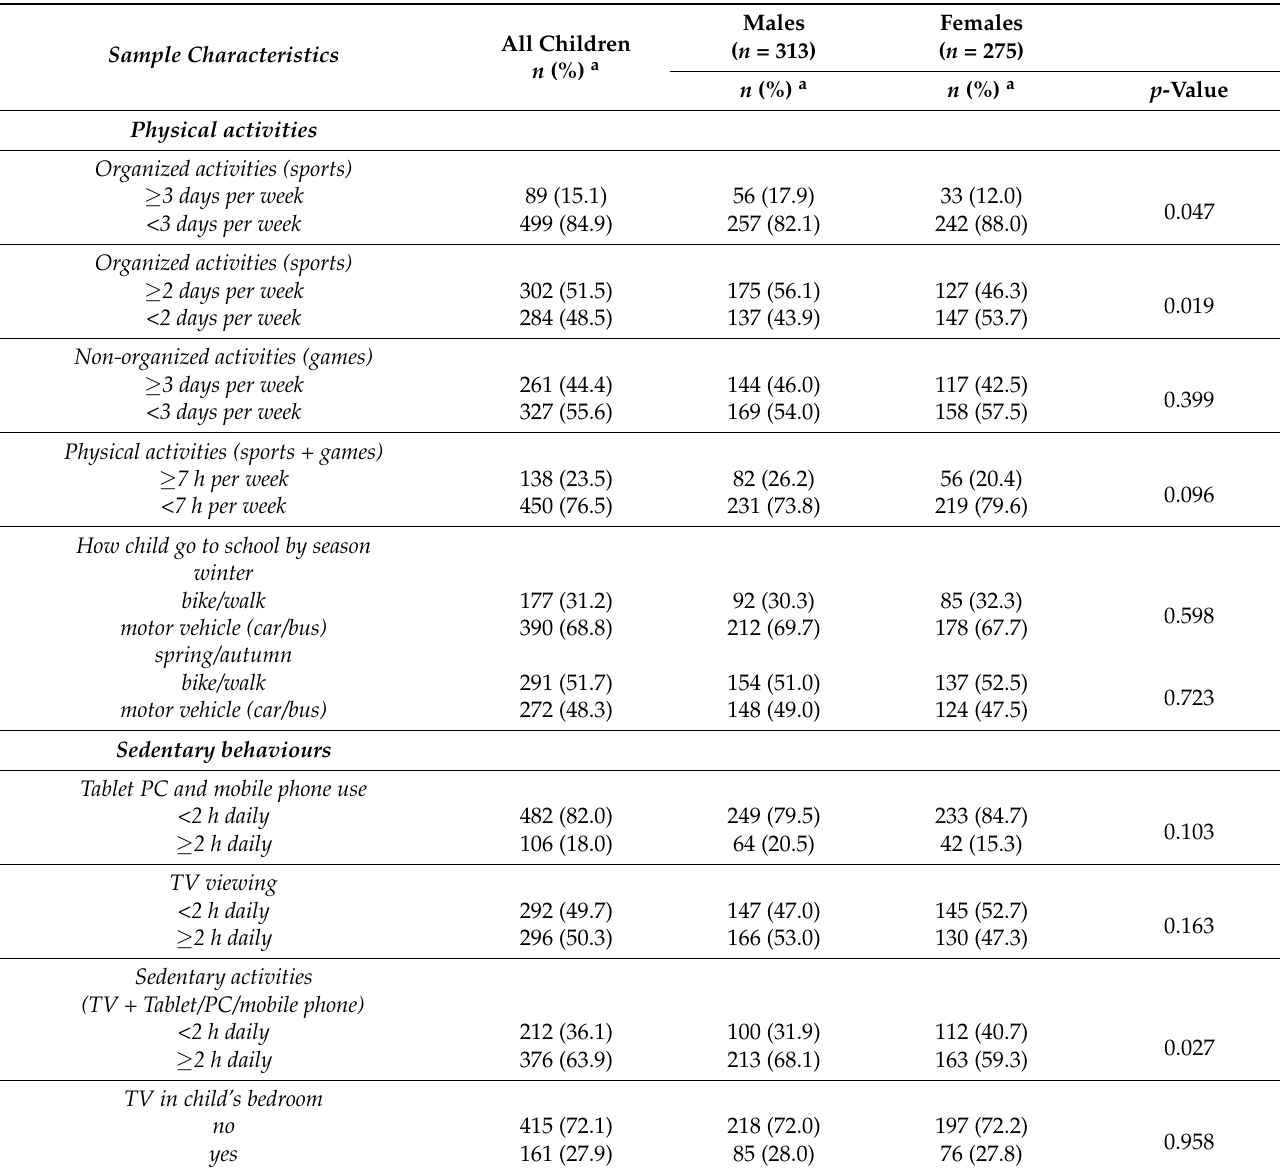
Table 1. Sample characteristics by child’s